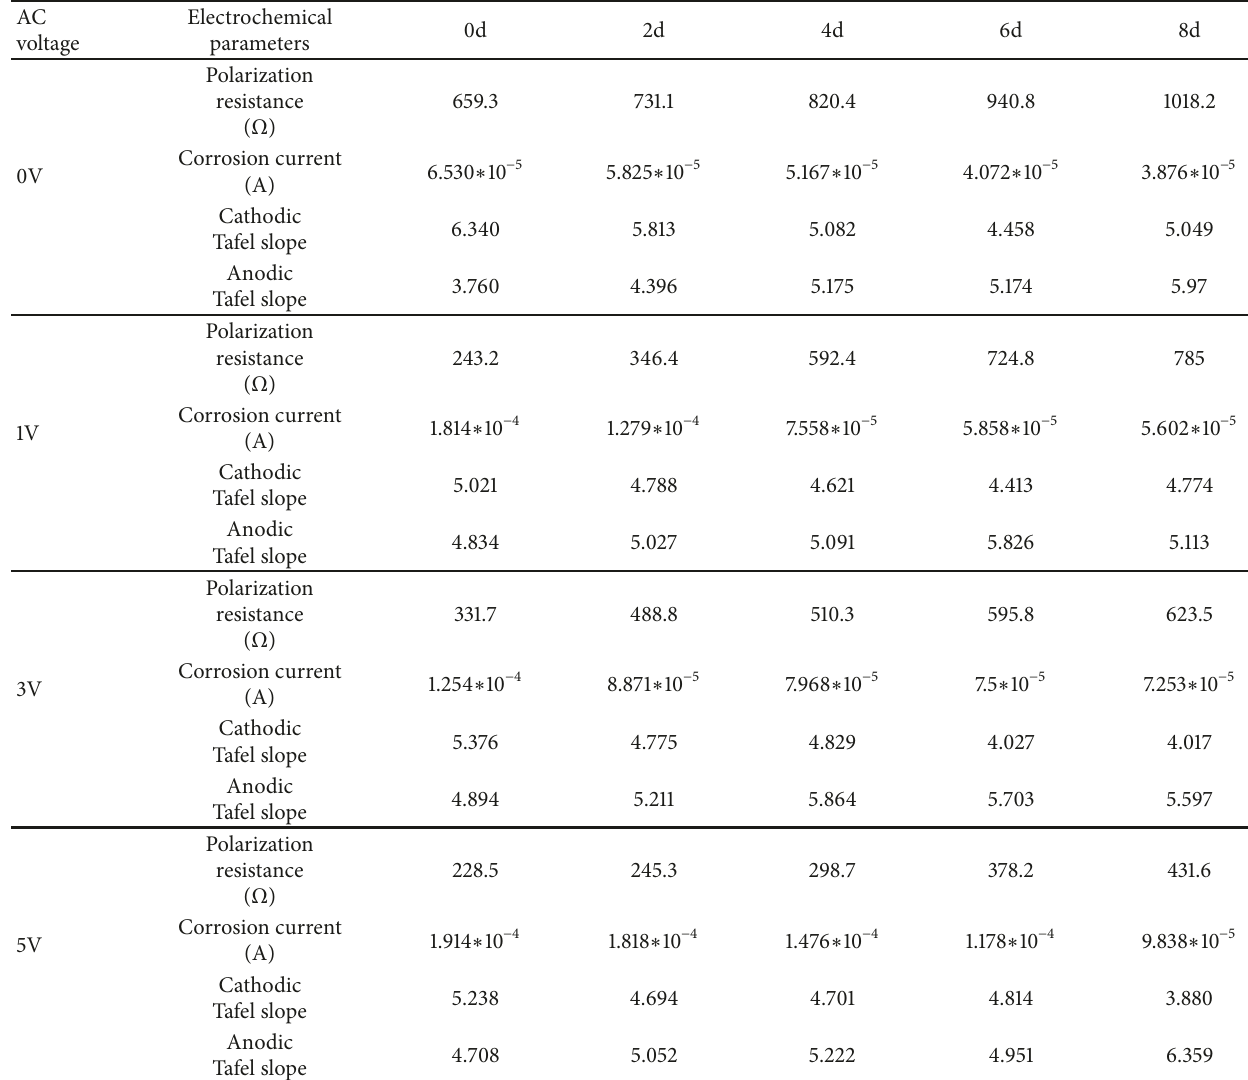
Table 1: The corrosion electrochemical parameters from polarization curves of the sacrificed anode under different AC voltages. AC